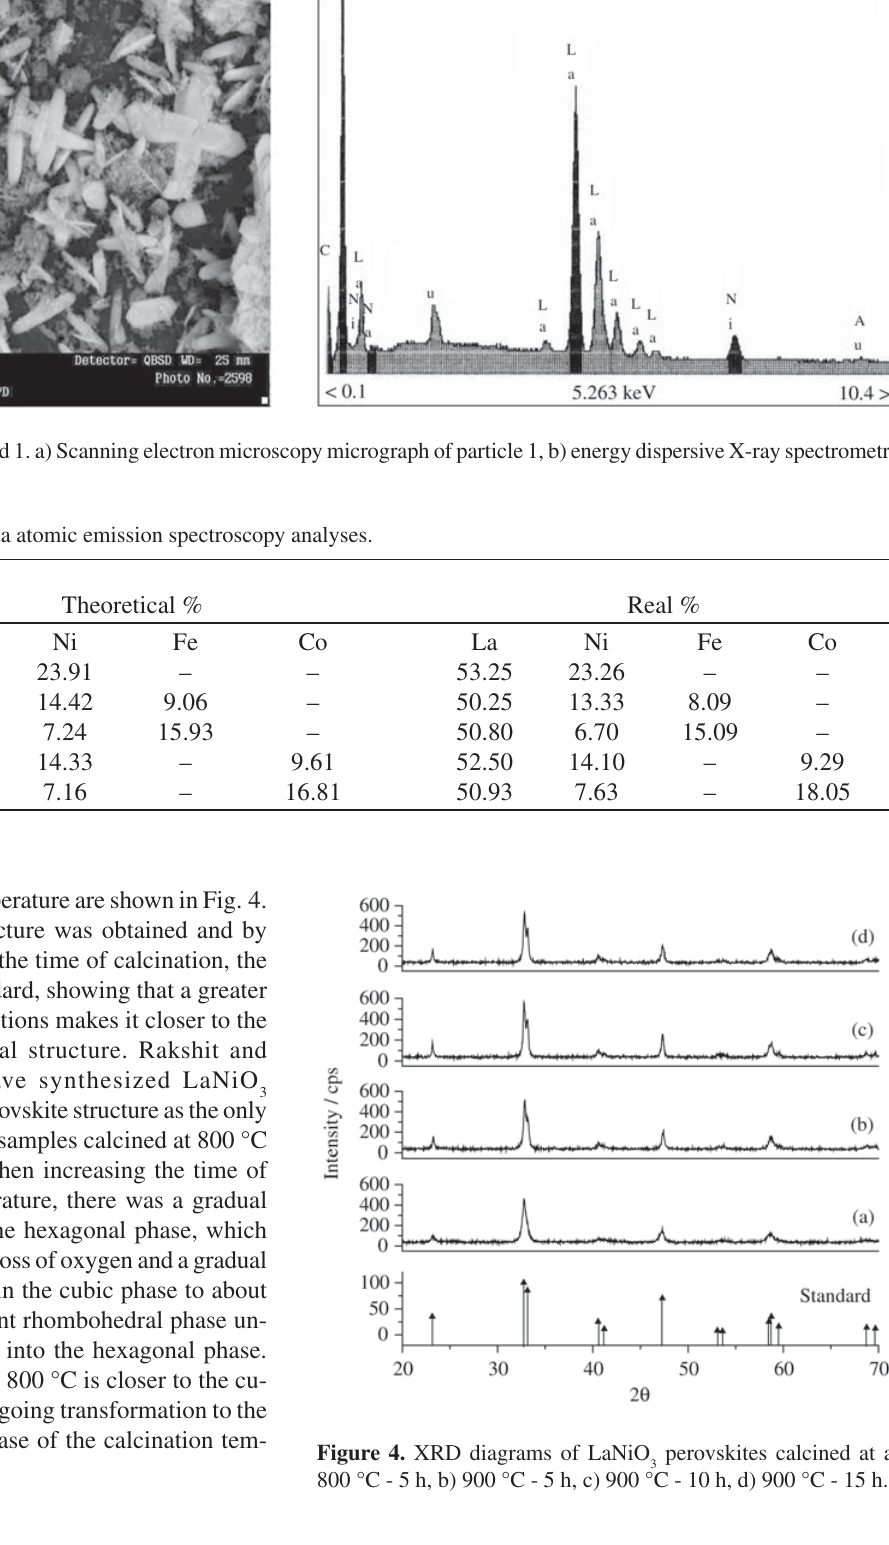
perovskites calcined at 3